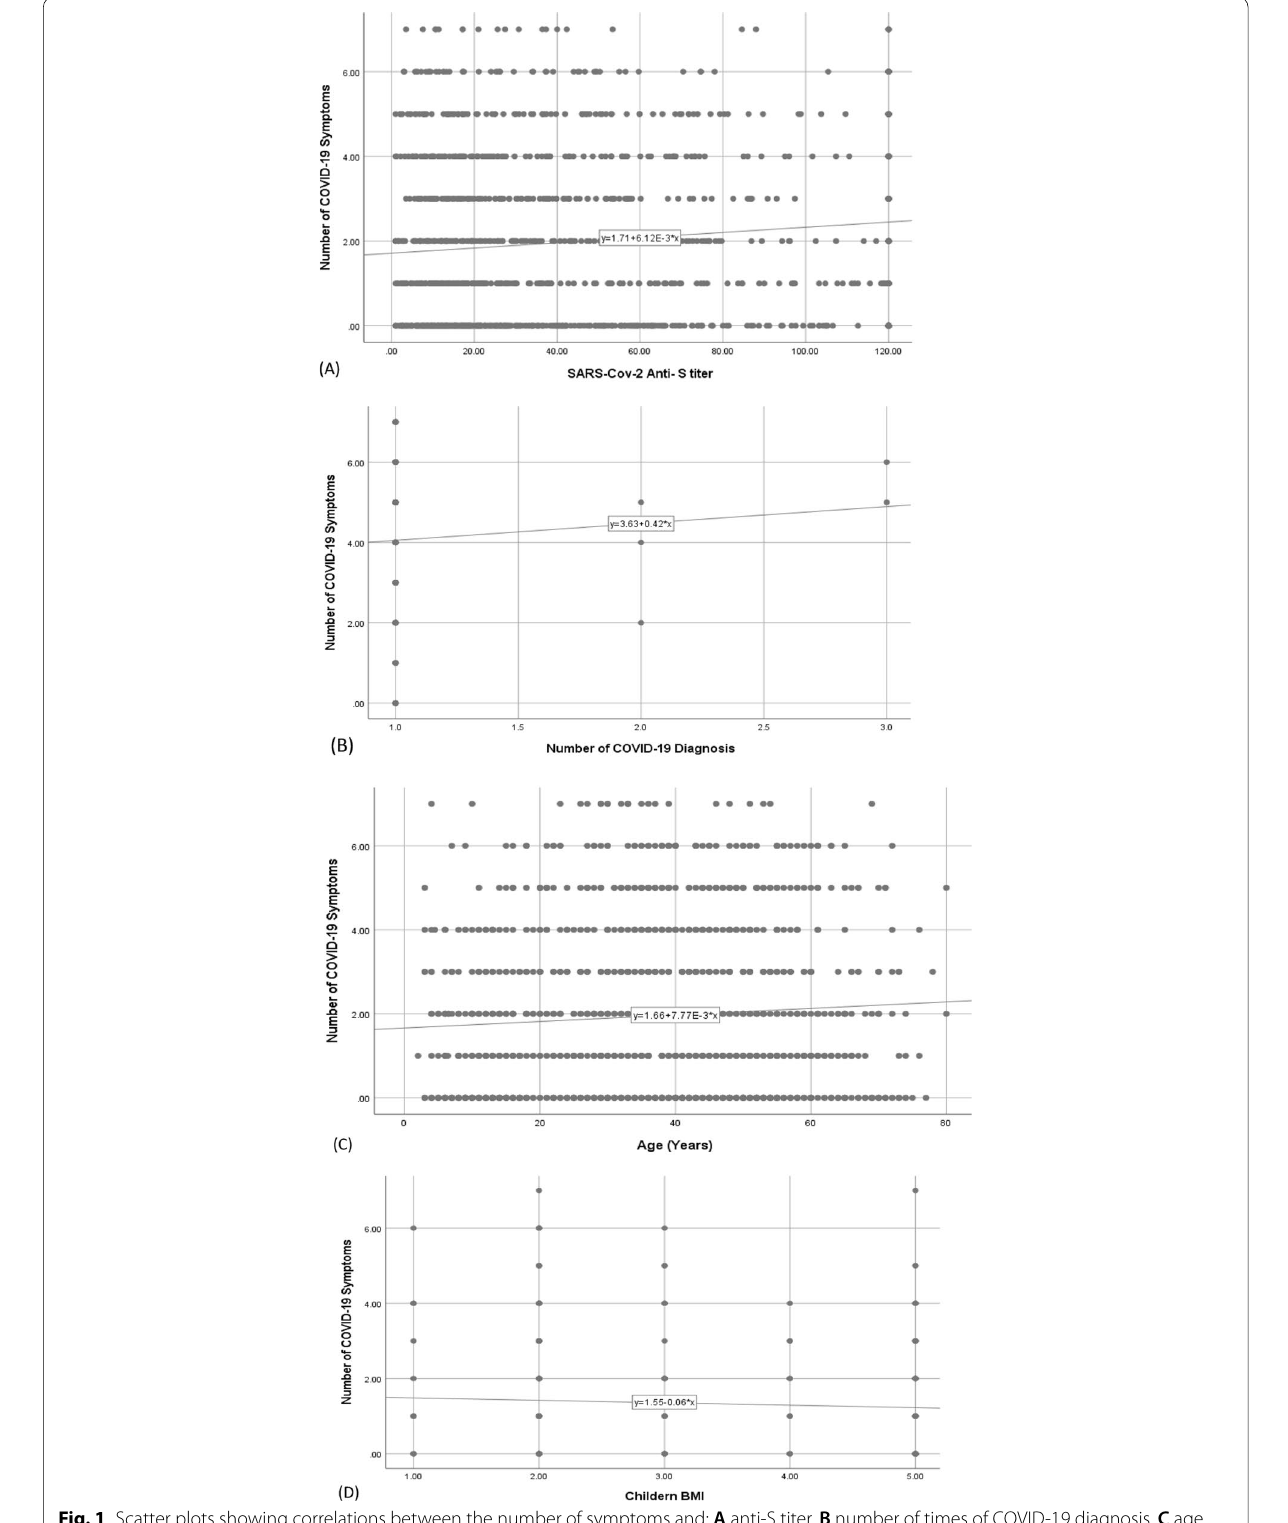
Fig. 1 Scatter plots showing correlations between the number of symptoms and: A anti‑S titer, B number of times of COVID‑19 diagnosis, C age (years), D children BMI, E adult BMI, F crowding index, G smoking